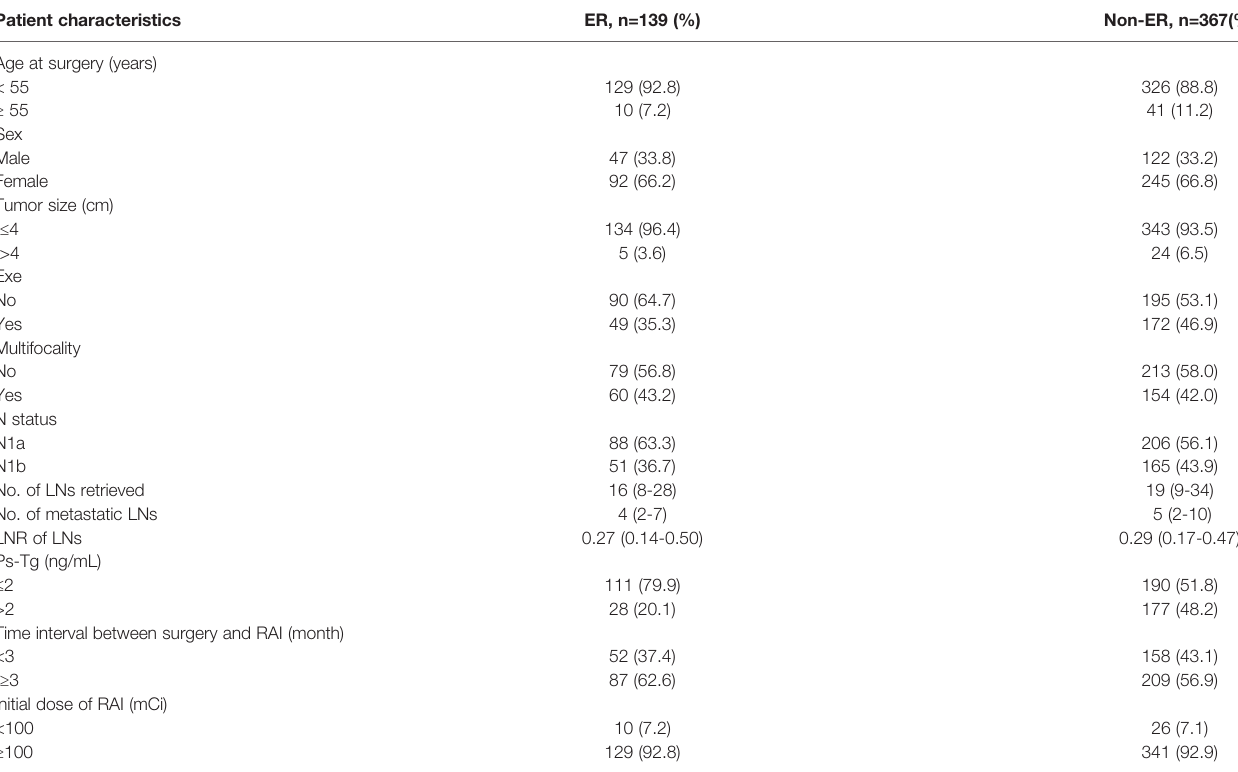
TABLE 1 | Clinicopathologic characteristics of patients with papillary thyroid cancer by response to initial therapy. Patient